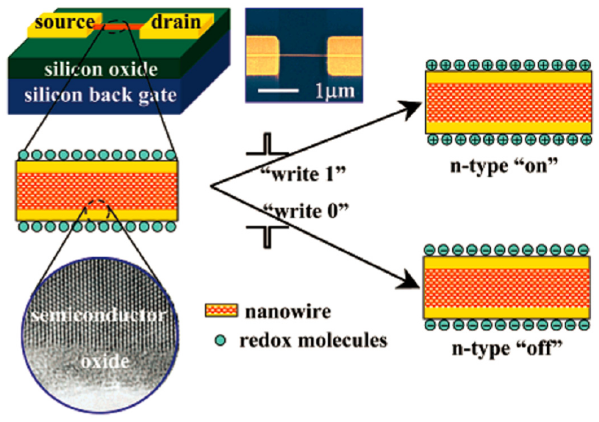
Figure 9. Nanowire-based non-volatile memory, with the nanowire surface functionalized with redox-active molecules. Logic on and off states are represented by different charged states. Reproduced with permission from [51], © American Chemical Society, 2002.